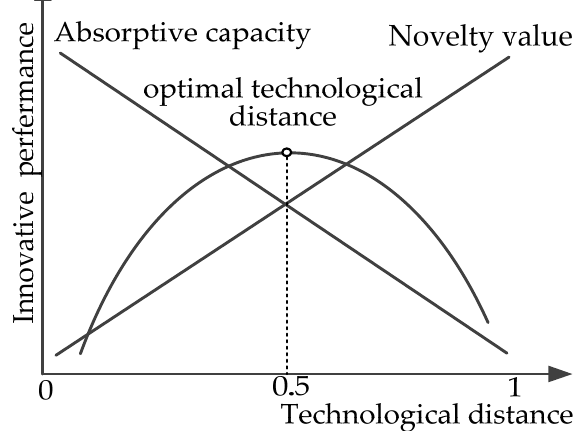
Figure 5. Inverted U-shaped and the optimal technological distance.